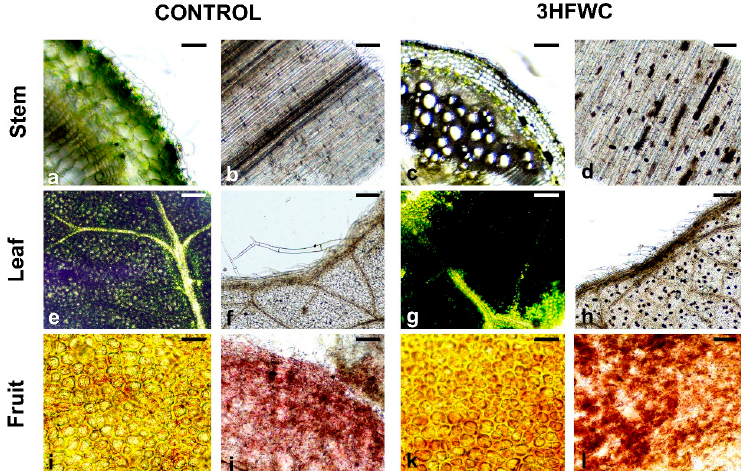
Figure 7. Histological analysis of control and 3HFWC grown plants after 12 weeks of growth. ( a – d ) Cross sections of stems of control ( a , b ) and 3HFWC-exposed plants ( c , d ), transversal sections ( a , c ), longitudinal sections ( b , d ); ( e – h ) Leaves of control ( e , f ) and 3HFWC ( g , h ) exposed plants, fresh leaf ( e , g ), bleached leaf ( f , h ); ( i – l ) Fruits of control ( i , j ) and 3HFWC-exposed plants ( k , l ), peal ( i , k ), pulp ( j , l ), Bars, 200 μ m.